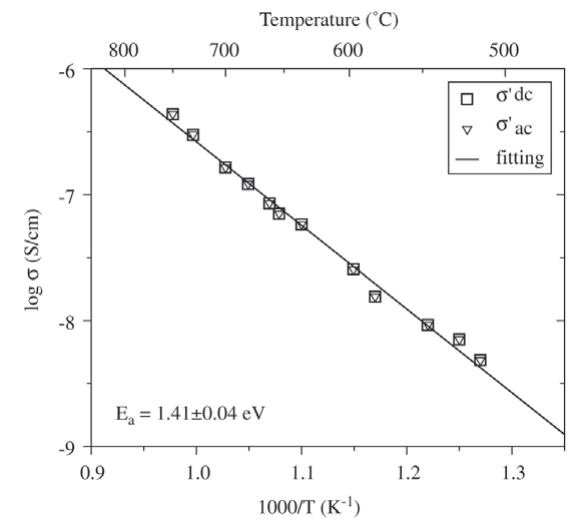
Figure 5. Arrhenius plots for dc and ac conductivities in BGO and σ ’ , respectively). The apparent activation energy indi- ( σ ’ dc ac cated in the graphic was deduced from the slope of the linear re- = 1/2 π RC. gression of the 0